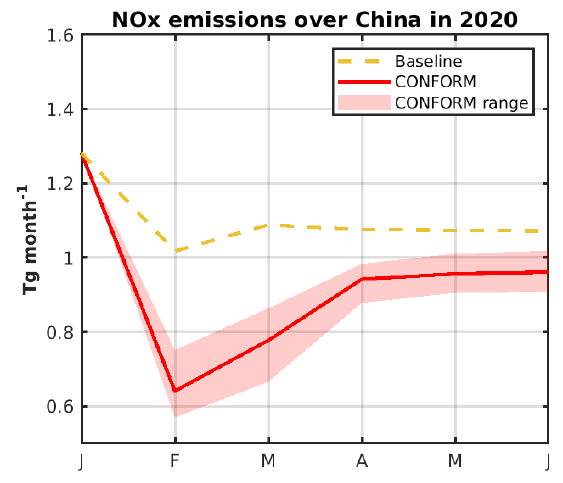
Figure 2. NO x emission estimates over China according to the baseline inventory CAMS-GLOB- ANT_v4.2-R1.1 (dashed), and the CONFORM emissions which account for the slowdown of economic activities due to the crisis (red). The pink shading represents the uncertainty ranges of the CONFORM emissions. The simulated monthly averaged columns at the satellite overpass time (13:30 local time for TROPOMI) are calculated by accounting for the averaging kernels and sampling times of valid data. The performed simulations are described in Table 1. Table 1. Description of the model simulations. All simulations use the same emissions for 2019 but differ regarding their 2020